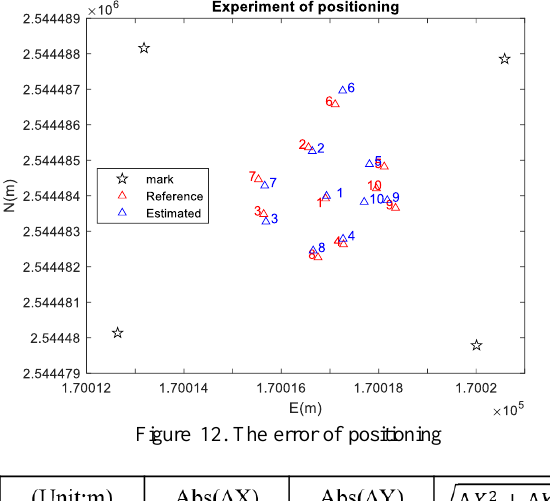
Figure 12. The error of positioning